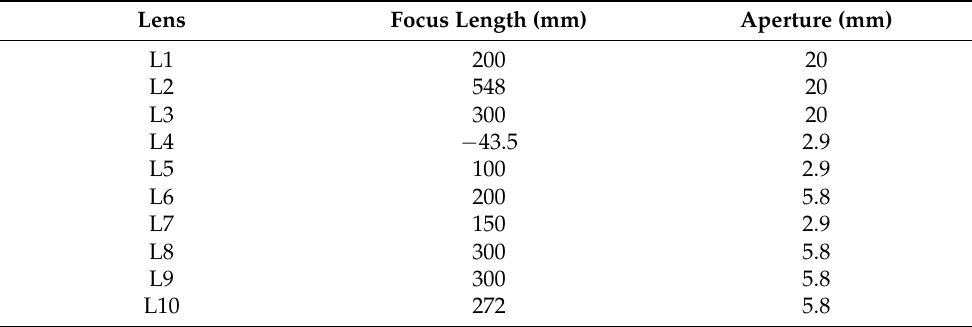
Table 1. Parameters of each lens in the LC–DM adaptive optics system.